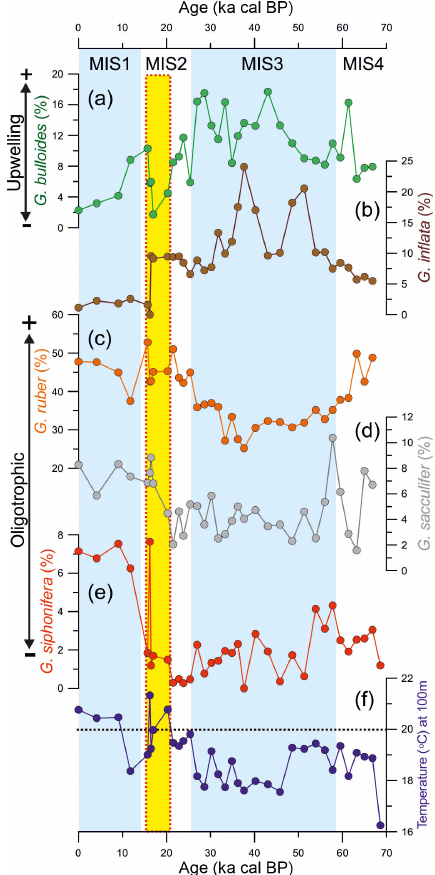
Figure 3. Relative abundance of planktonic foraminifera species and reconstructed subsurface temperature (100m water depth) from core JPC-17 over the last 70kyr. (a) Relative abundance of Globige- rina bulloides , (b) Globorotalia inflata , (c) Globigerinoides ruber , (d) Globigerinoides sacculifer and (e) Globigerinella siphonifera . (e) Temperature at a water depth of 100m. The black dashed line in (f) indicates the 20 ◦ C isotherm which defines the modern maxi- mum temperature of South Atlantic Central Water (Castelao et al., 2004), the water mass entering the photic zone in the upwelling sites of the southern Brazilian margin. The vertical yellow bar marks the interval with reversed radiocarbon ages listed in Table